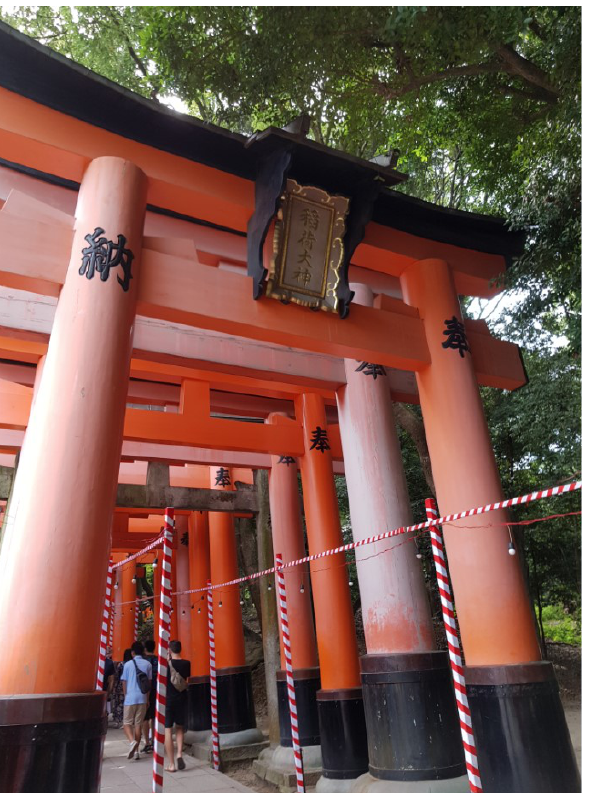
The drain next to the